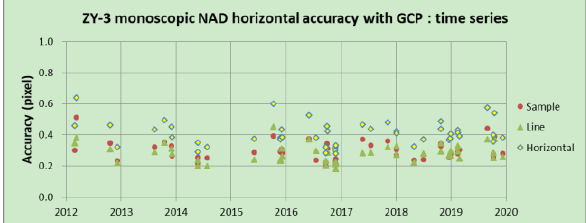
Figure 8. ZY-3 monoscopic NAD horizontal accuracy